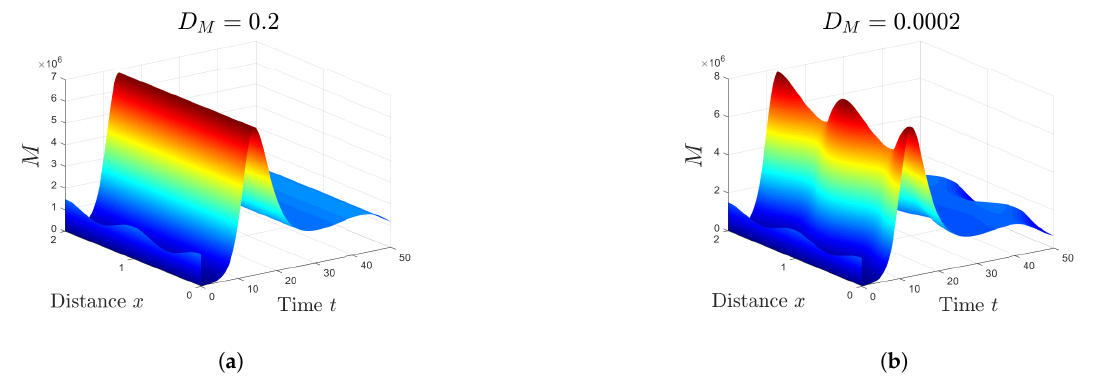
Figure 7. The effect of changing the diffusion coefficient on the concentration of free merozoites M at the beginning of infection. All parameters are identical to those used in Figure 5, while the diffusion coefficient D M is changed from ( a ) D M = 0.2 to ( b ) D M = 0.0002